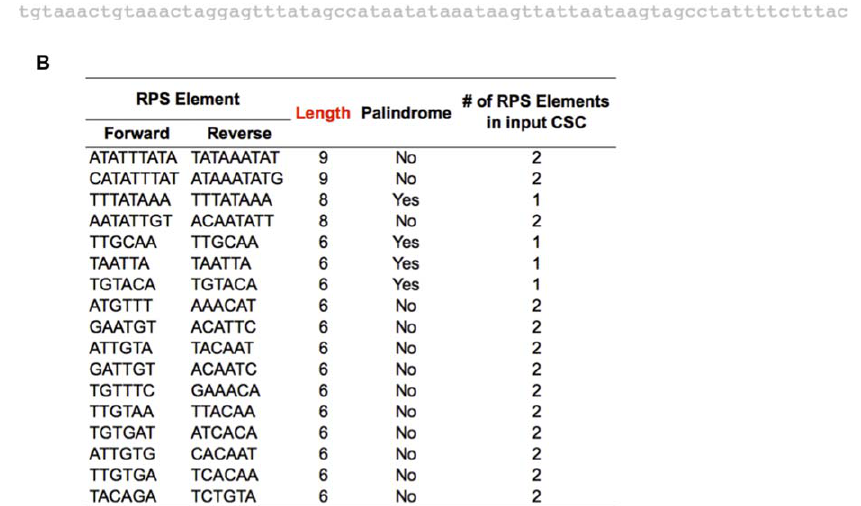
Figure 2. An EvoPrint view of a genomic segment of human DNA selected and then screened for mutations. (A) A multiple species comparison was performed where bases conserved in all but one of the test species, relaxed EvoPrint, appear as black uppercase letters (these alignments were among Human, Marmoset, Chimpanzee, Rhesus-Monkey, Horse, Platypus and Opossum) and are displayed in context with non- conserved bases (lower case, grey) spanning the entire 804 bp element shown in blue. (B) Analysis of the repetitive and palindromic structure of the EvoPrint using cis -Decoder identifies further substructure of its conserved sequence blocks (CSB). Distinct elements ( . 6 bp) are highlighted in yellow. These CSC analyzed and presented are contained within the element in common [ . 50% conservation between human and zebrafish, outlined in red] where most variants were detected.